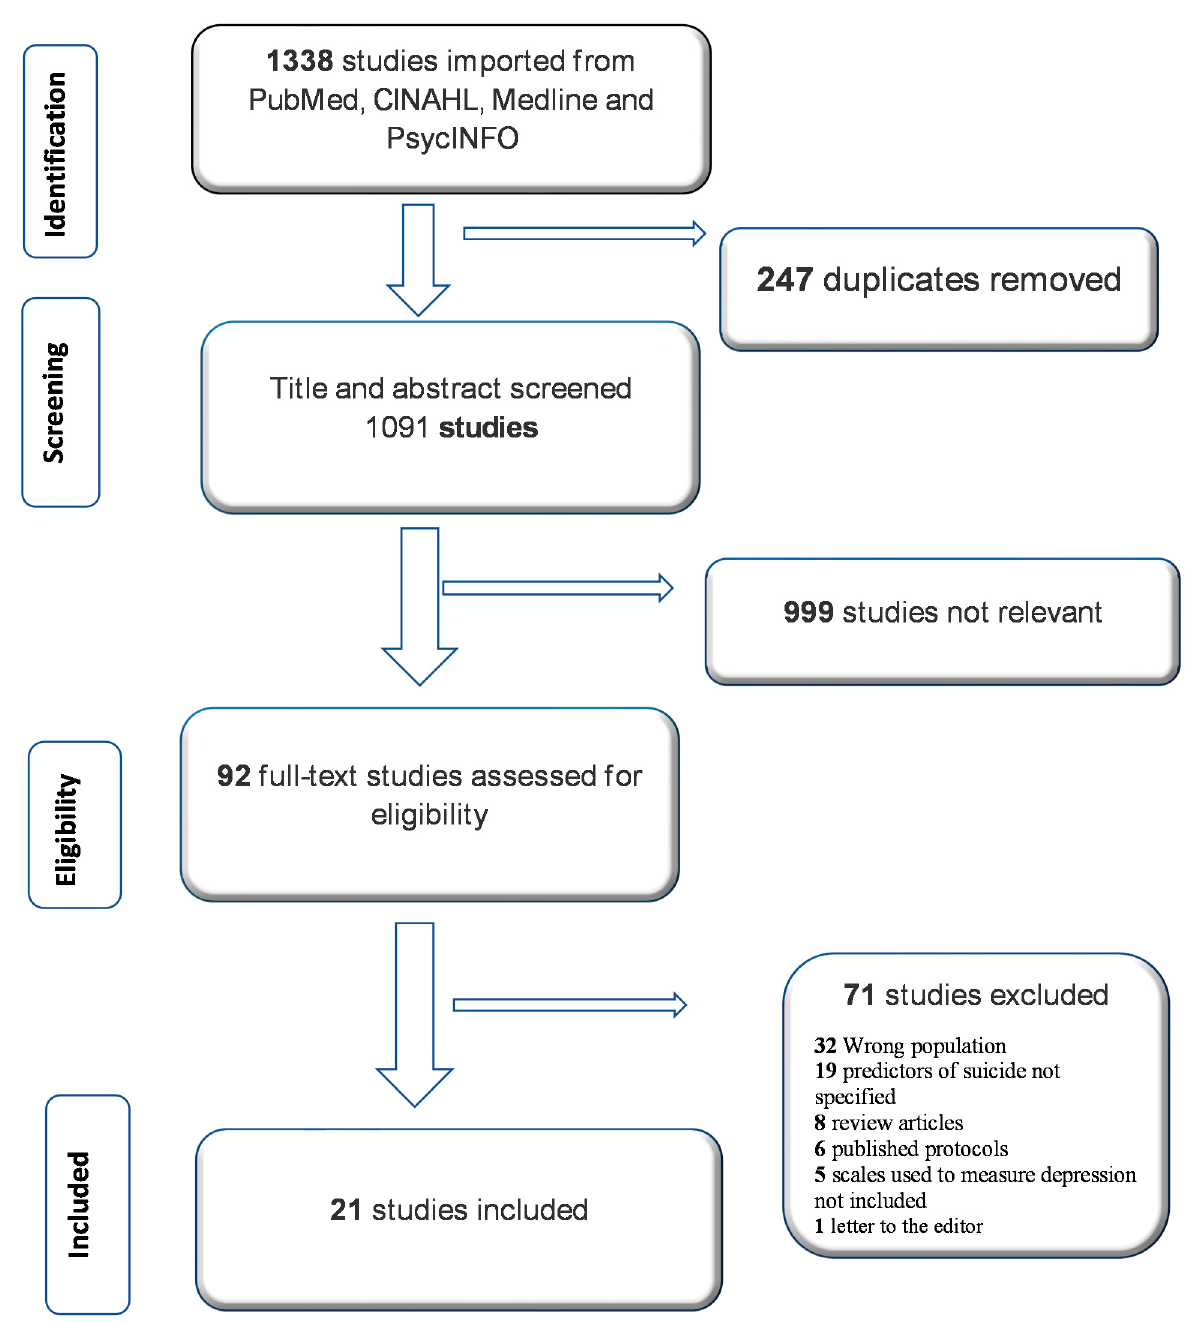
Figure 1. PRISMA flowchart of study selection. Table 1. Prevalence of major depressive disorder among the